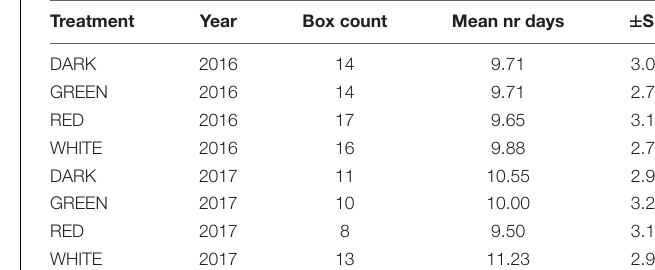
FIGURE 1 | Example of temperature logger placed in the nest cup just before or during incubation. Loggers were covered with panty hose and attached to a piece of wire to prevent birds from removing it from the nest.